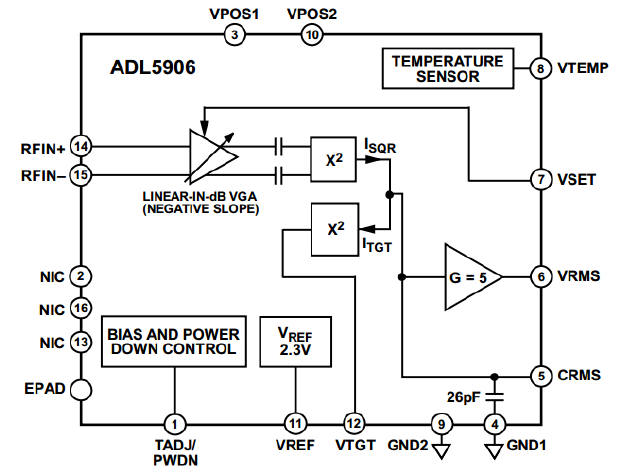
Fig. 6. ADL5906 functional